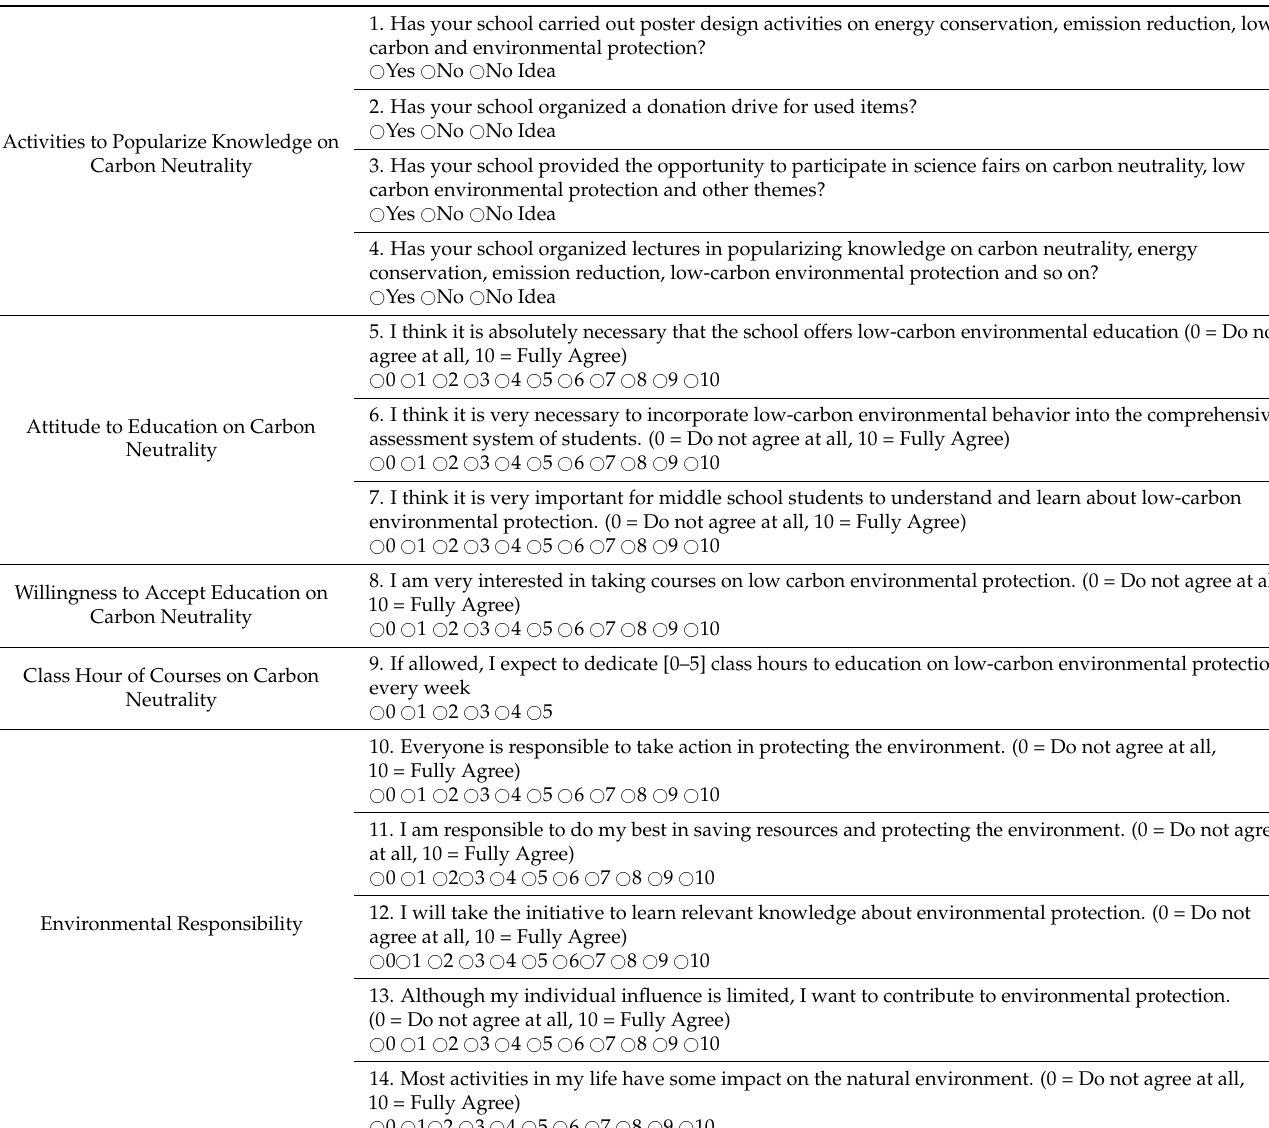
Table A1. Content of the